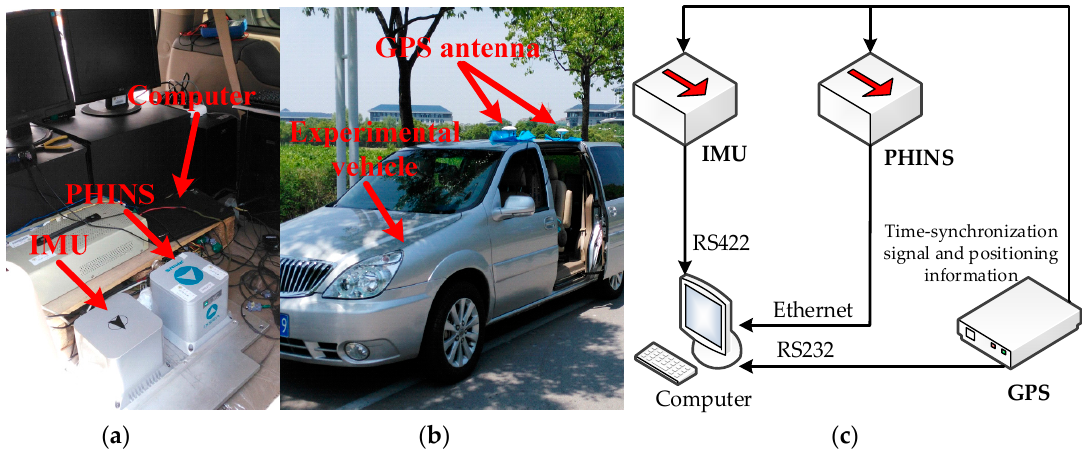
Figure 9. ( a ) PHINS and IMU installation diagram; ( b ) experimental vehicle; ( c ) structure of the vehicle test equipment.